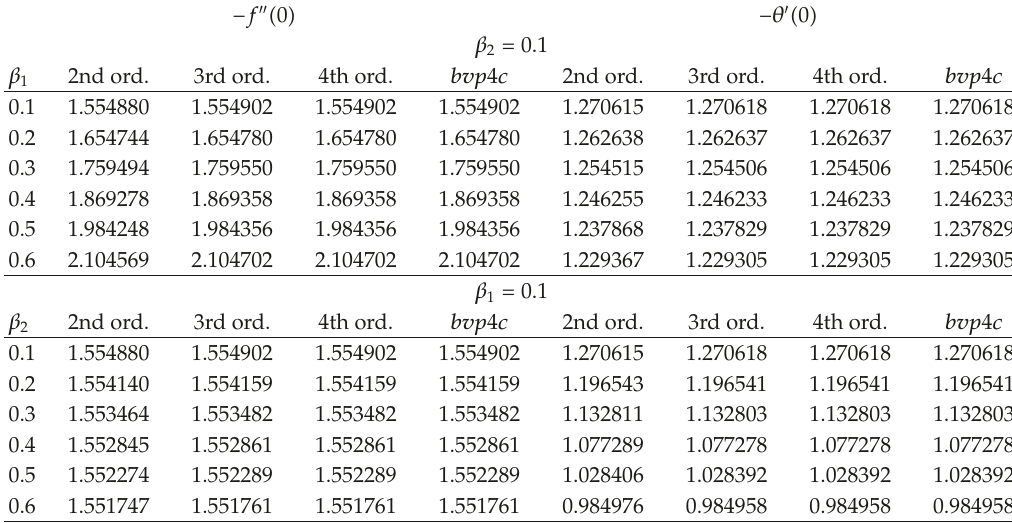
Table 1: Comparison between the present successive linearisation method (cid:6) SLM (cid:7) results and the bvp4c numerical results for − f (cid:6)(cid:6) (cid:6) 0 (cid:7) and − θ (cid:6) 0 (cid:7) for various values of β 1 and β 2 when Pr (cid:5) 0 . 72; M (cid:5) 1; m (cid:5) 1; S (cid:5) 0 . 8.